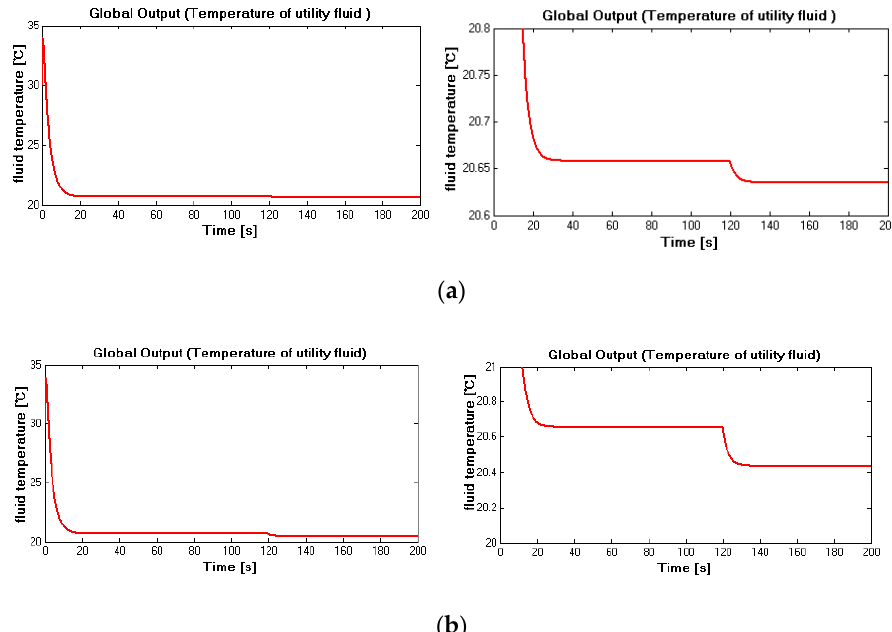
Figure 10. ( a ) Measured T H (noise-free situation) in case 2; ( b ) measured T H (noise-corrupted situation) in case 2.